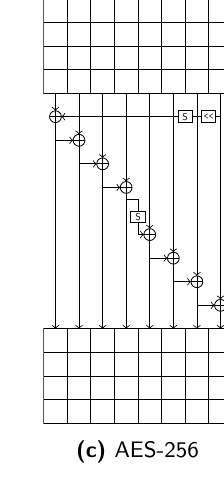
Figure 2: Key schedule round functions for each AES version, from